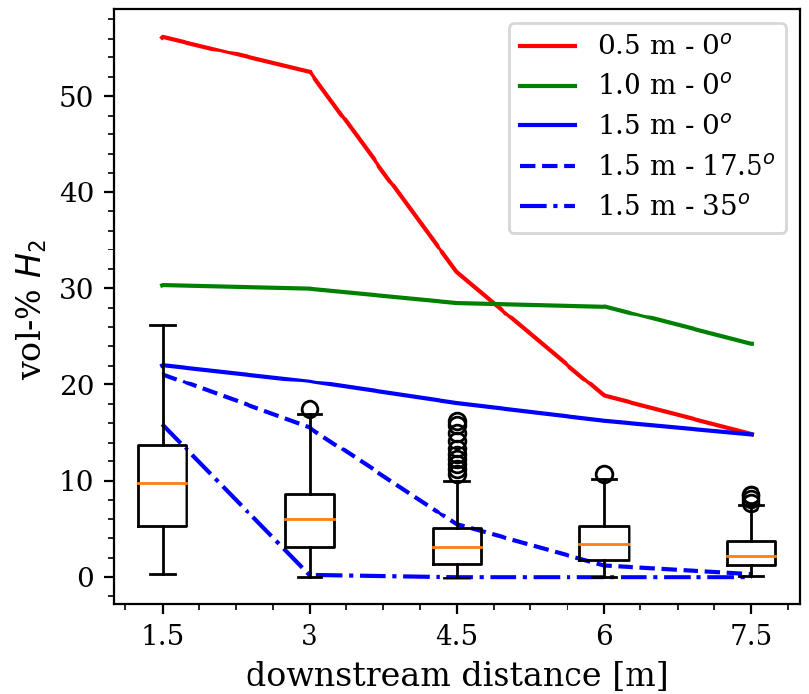
Figure 3. Box-and-whisker plots show the measured concentrations from HSE – Test 6 (data were extracted from Figure 23 in [9]). The hydrogen concentrations from Fuego simulations are shown going downstream with the measurement points at a height of 0.25 m along the centerline (solid line), at a 17.5 ◦ (dashed line) and at a 35 ◦ (dot-dashed line) horizontal angle from the wind direction. Results for the three pool diameters are shown as described in the legend: 0.5 m (red), 1.0 m (green), and 1.5 m